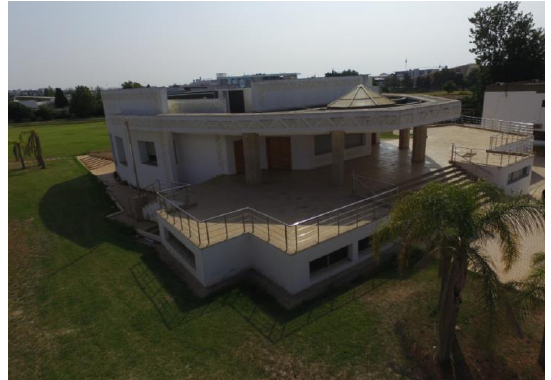
Figure 1 . The great Amphitheater of Agronomy and Veterinary Institute Hassan II (Rabat, Morocco).